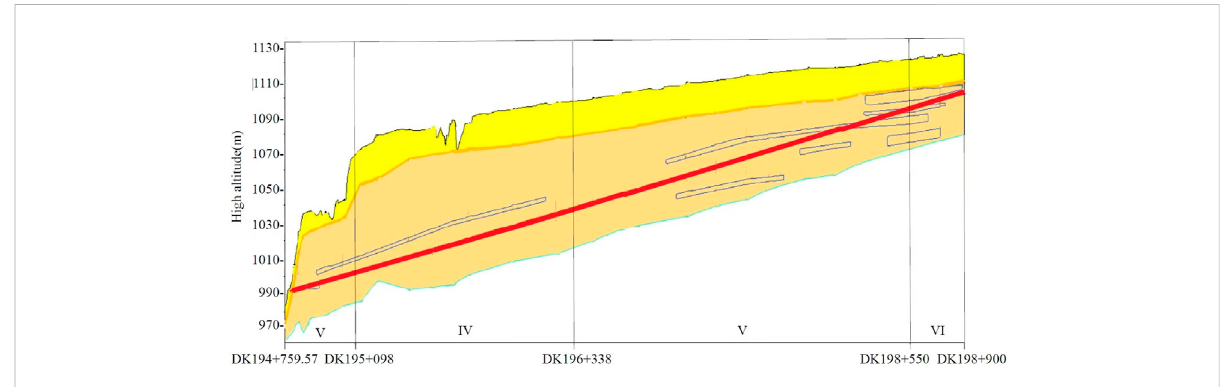
FIGURE 1 Pro fi le of the Luochuan tunnel.